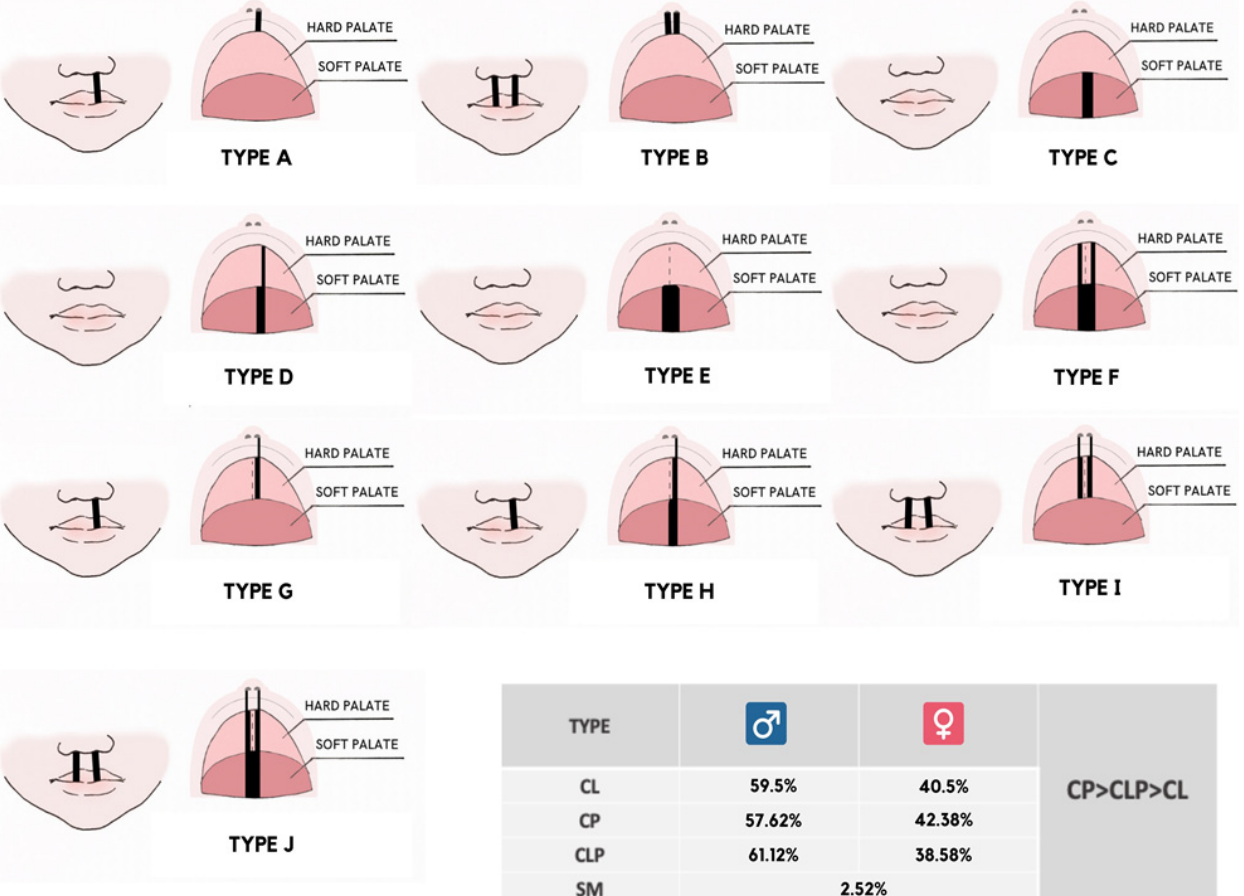
Table 1. Phenotypic description by LAHSHAL classification [CA: cleft alveolus; CL: cleft lip; CP: cleft palate; CL/P: cleft lip with or without palate].